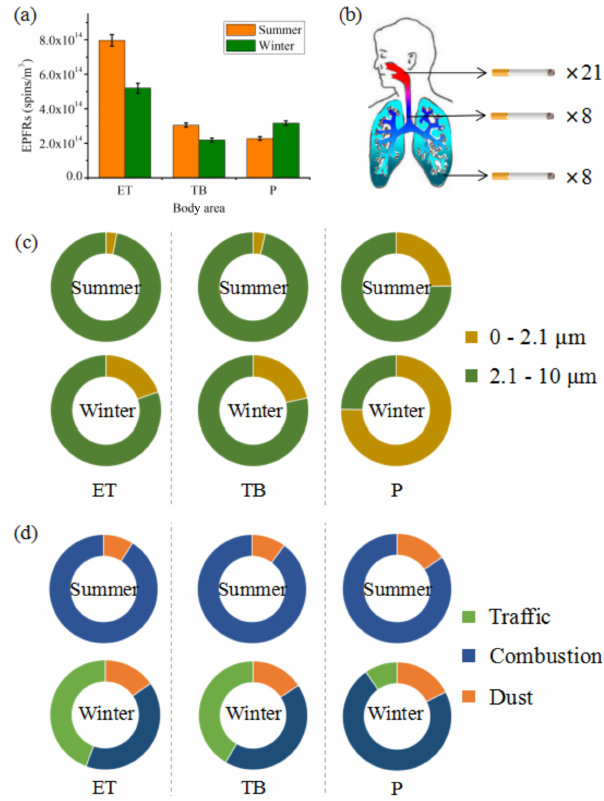
Figure 4. Exposure risks to EPFRs. (a) EPFR exposure in the ET, TB and P regions. (b) Cigarette exposure to EPFRs in the human respiratory system. (c) Exposure ratio of EPFRs with different par- ticle sizes in different areas of the respiratory system. (d) Contribu- tion of EPFRs from different sources to different areas of the respi- ratory